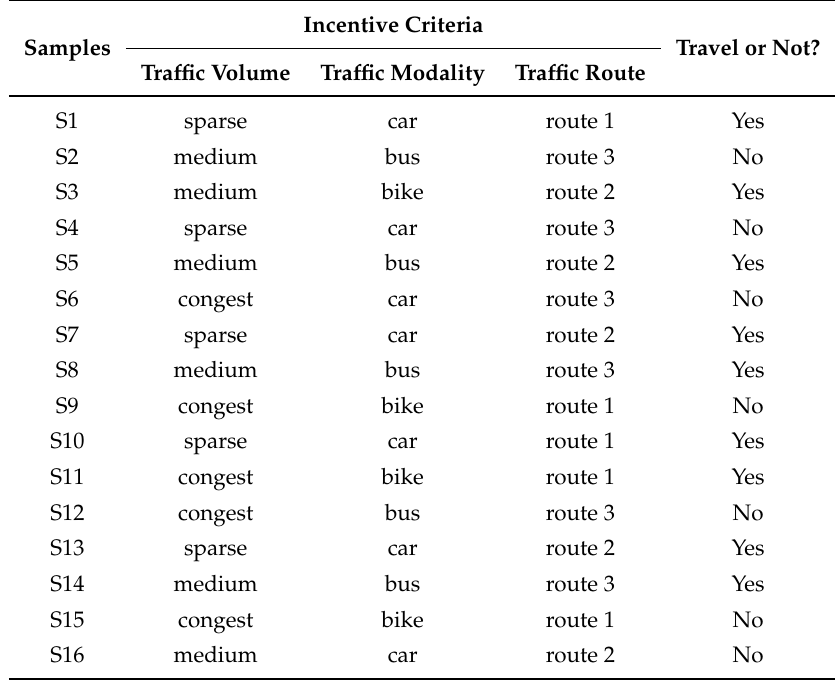
Table 3. The sample data of travellers (grouped as S ) applied in the ID3